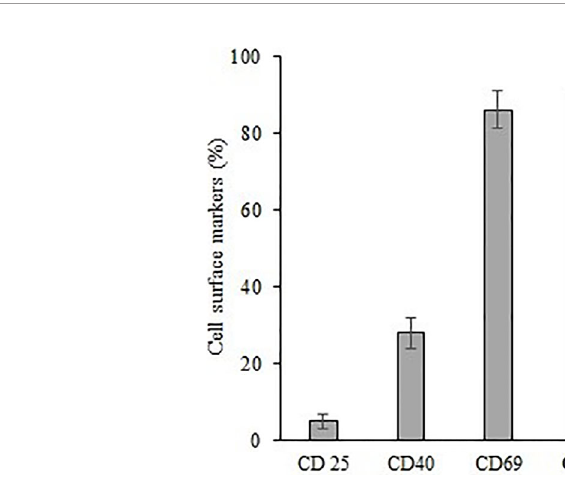
FIGURE 7 | Expression of cell surface markers CD 25, CD40, CD69, CD80, CD86, HLA-DR, HLA-ABC on expanded gd T cells.